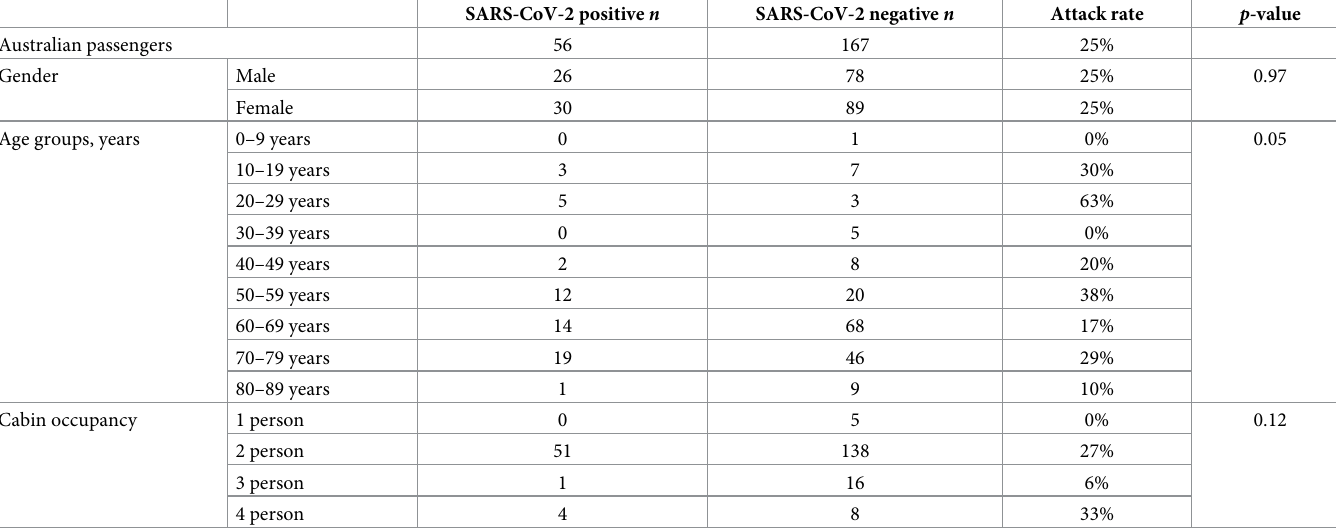
Table 1. Characteristics of Australian passengers on the Diamond Princess, March 2020 (n = 223).